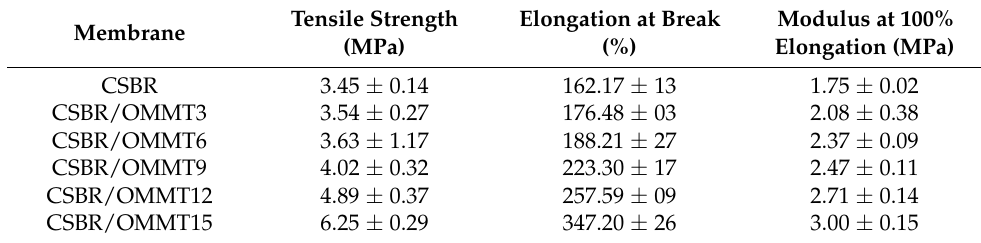
Table 5. Mechanical properties of CSBR and CSBR/OMMT nanocomposite membranes. Tensile Strength Membrane